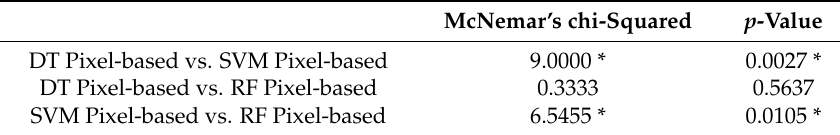
Table 4. Statistically significant comparison between three pixel-based machine learning algorithms.